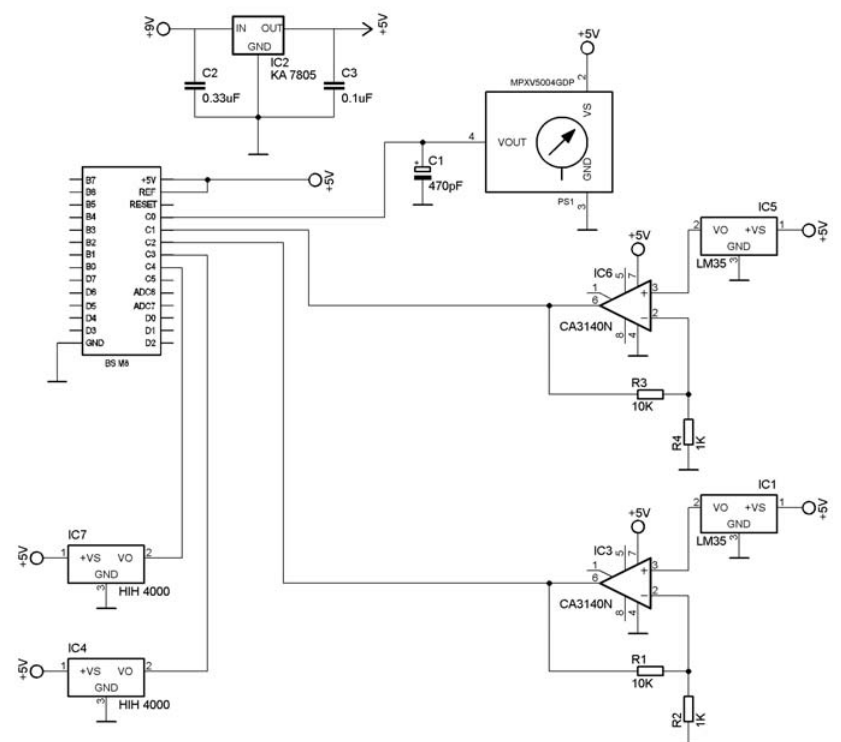
Figura 3. Diagrama esquemático do circuito eletrônico do sistema de aquisição de